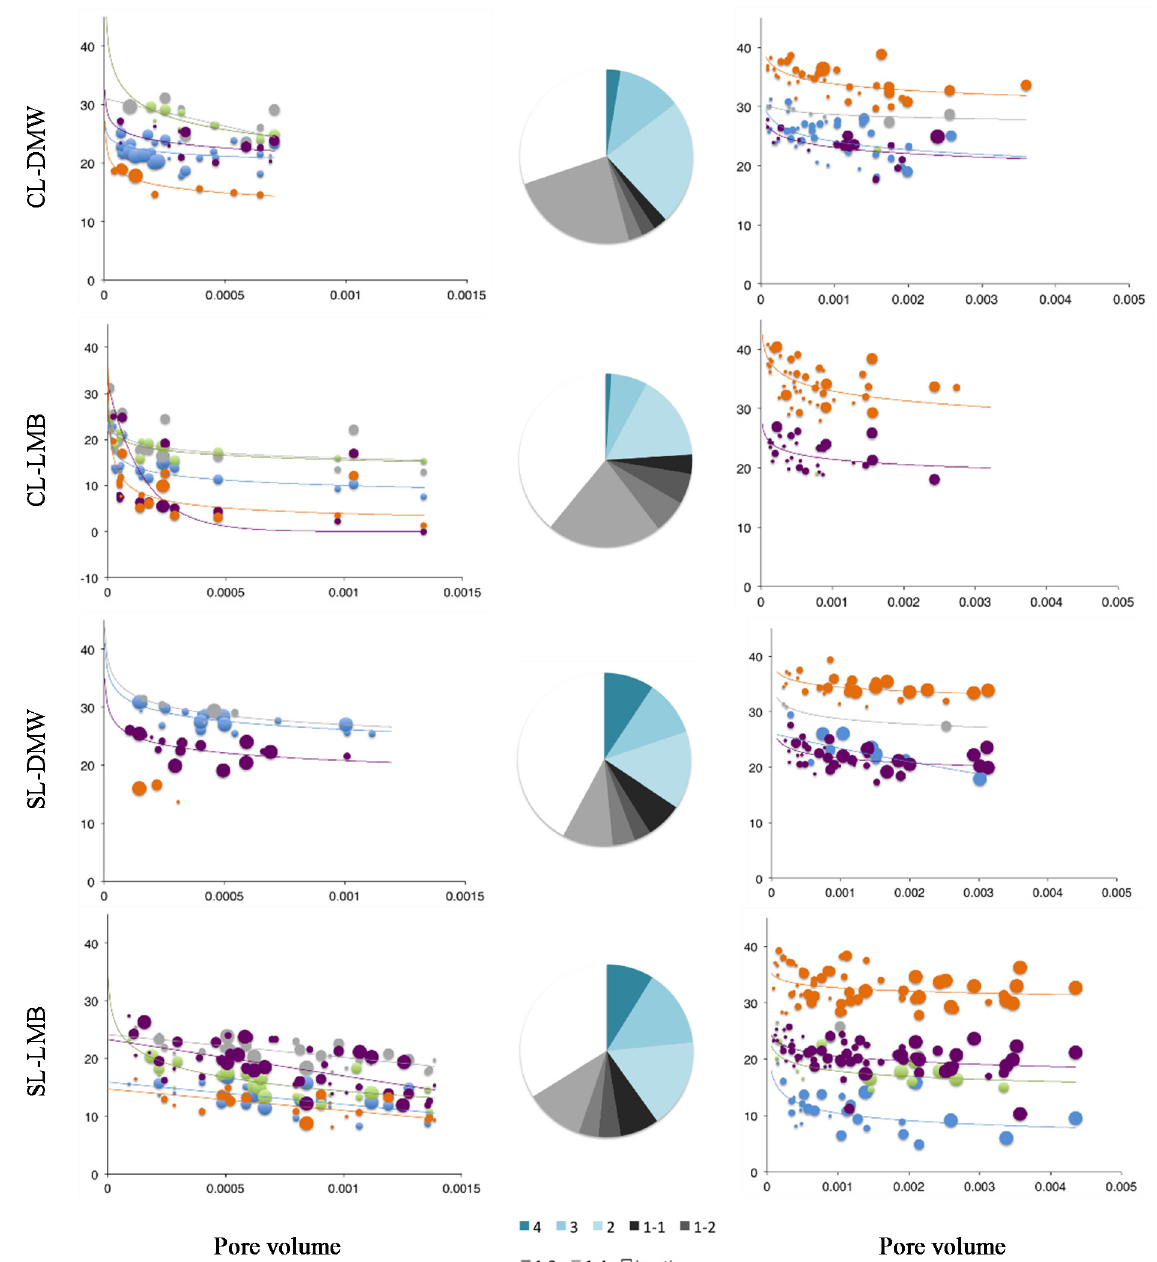
Figure 1. Filtration coefficients for 1st and last drainage event. Last drainage event received double the irrigation volume. Size of bubble describes the flow continuity for the respective collector ( i.e. , 4 = Area drained at all four events). Pie charts summarize the proportion of collectors’ activity with events. Blue shades describe, clockwise, the proportion of collectors active for four, three or two events. The black and grey shades describe the proportion of collectors active for a single event; e.g., 1–2 describes the proportion of collectors active only once during irrigation Event 2. White slices summarize the proportion of collectors inactive for the entire duration of the experiment. C–clay